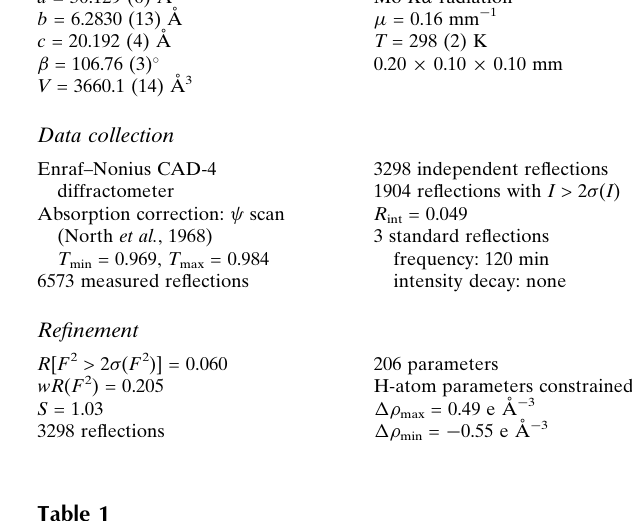
Hydrogen-bond geometry (A˚ , (cid:2)